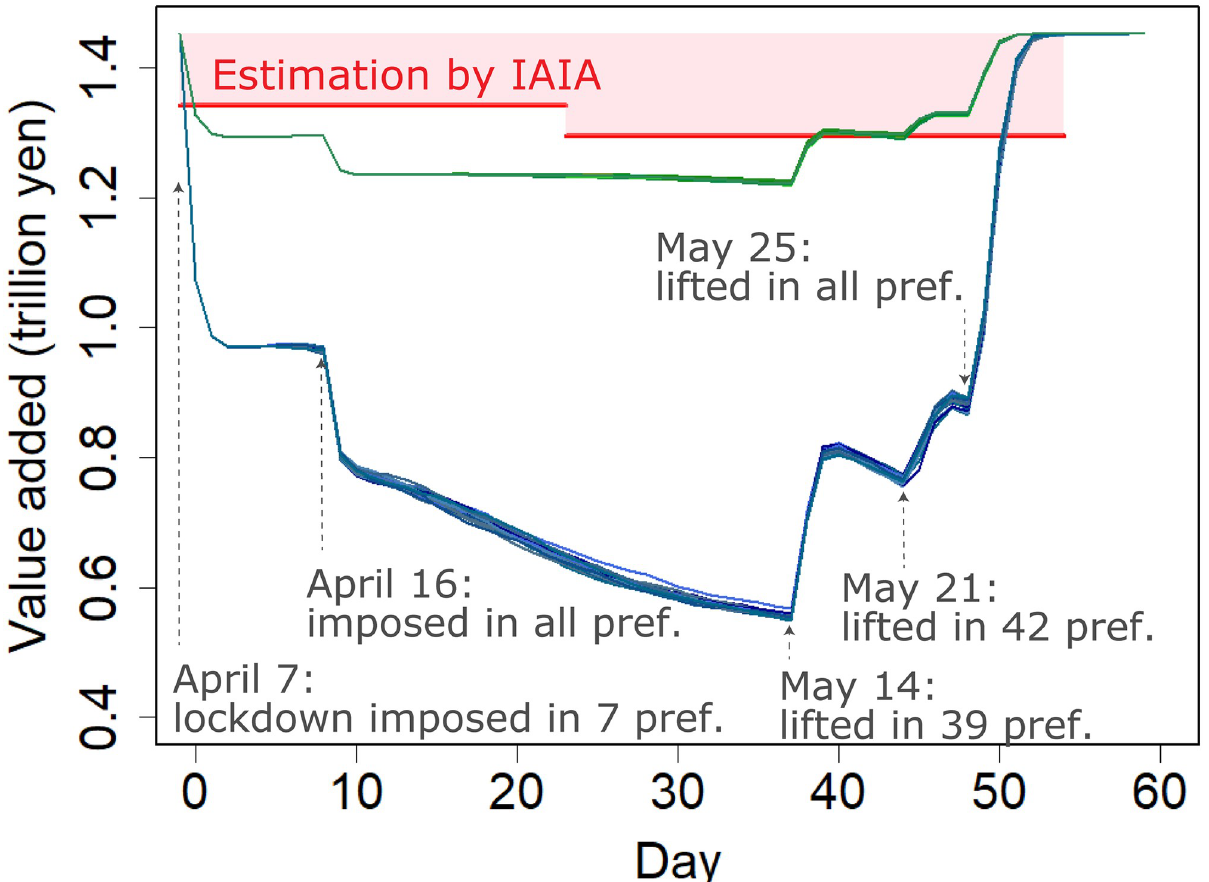
Fig 2. Simulations of value added (GDP) during the actual lockdown. The blue and green lines indicate the simulation results given the sector- specific rates of reduction in production capacity assumed in the literature [9, 36] and shown in S1 Table and the 26.7% of those rates to calibrate the actual production dynamics, respectively. Each line represents the daily GDP from one Monte Carlo run. The red segments indicate the daily GDP estimated from pre-lockdown GDP and the post-lockdown monthly Indices of All Industry Activity (IAIA) for April and May.